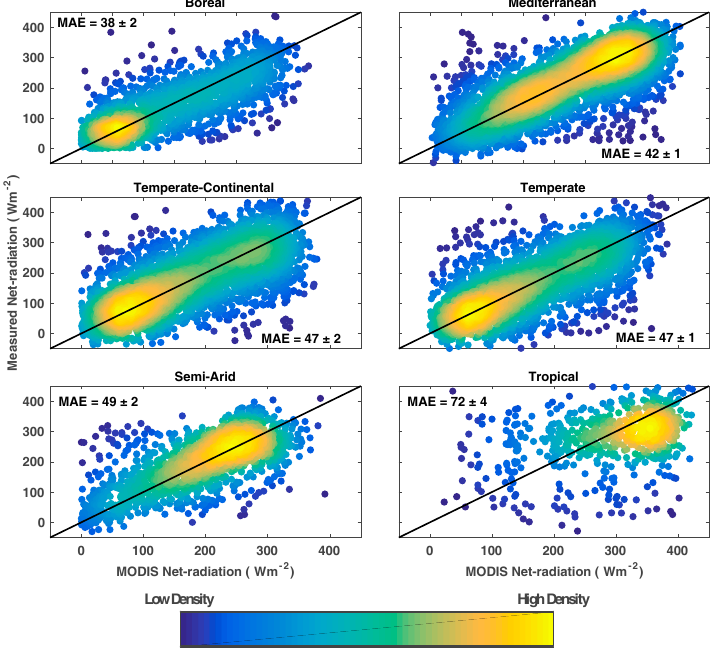
Figure 5. Comparison between daytime MODIS and measured net-radiation in six different climate types. MAE denotes mean absolute error in W · m − 2